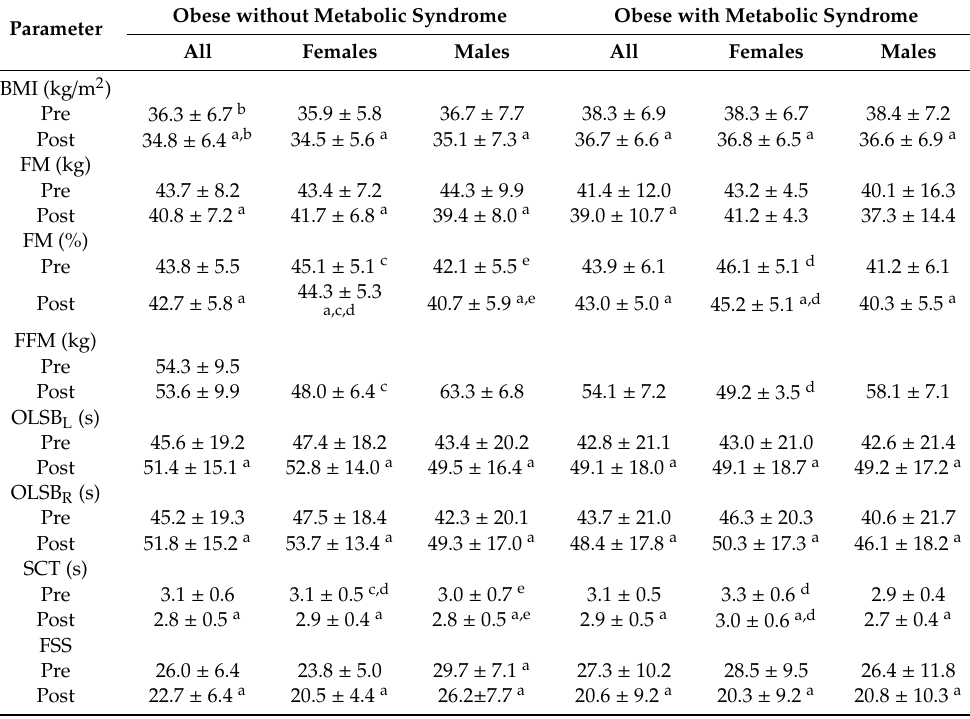
Table 2. E ff ects of a three-week body weight reduction program on BMI (body mass index), OLSB (one-leg standing balance), SCT (stair climbing test) and FSS (fatigue severity score) in the recruited pediatric population, including obese subjects with or without metabolic syndrome, subdivided into females and males